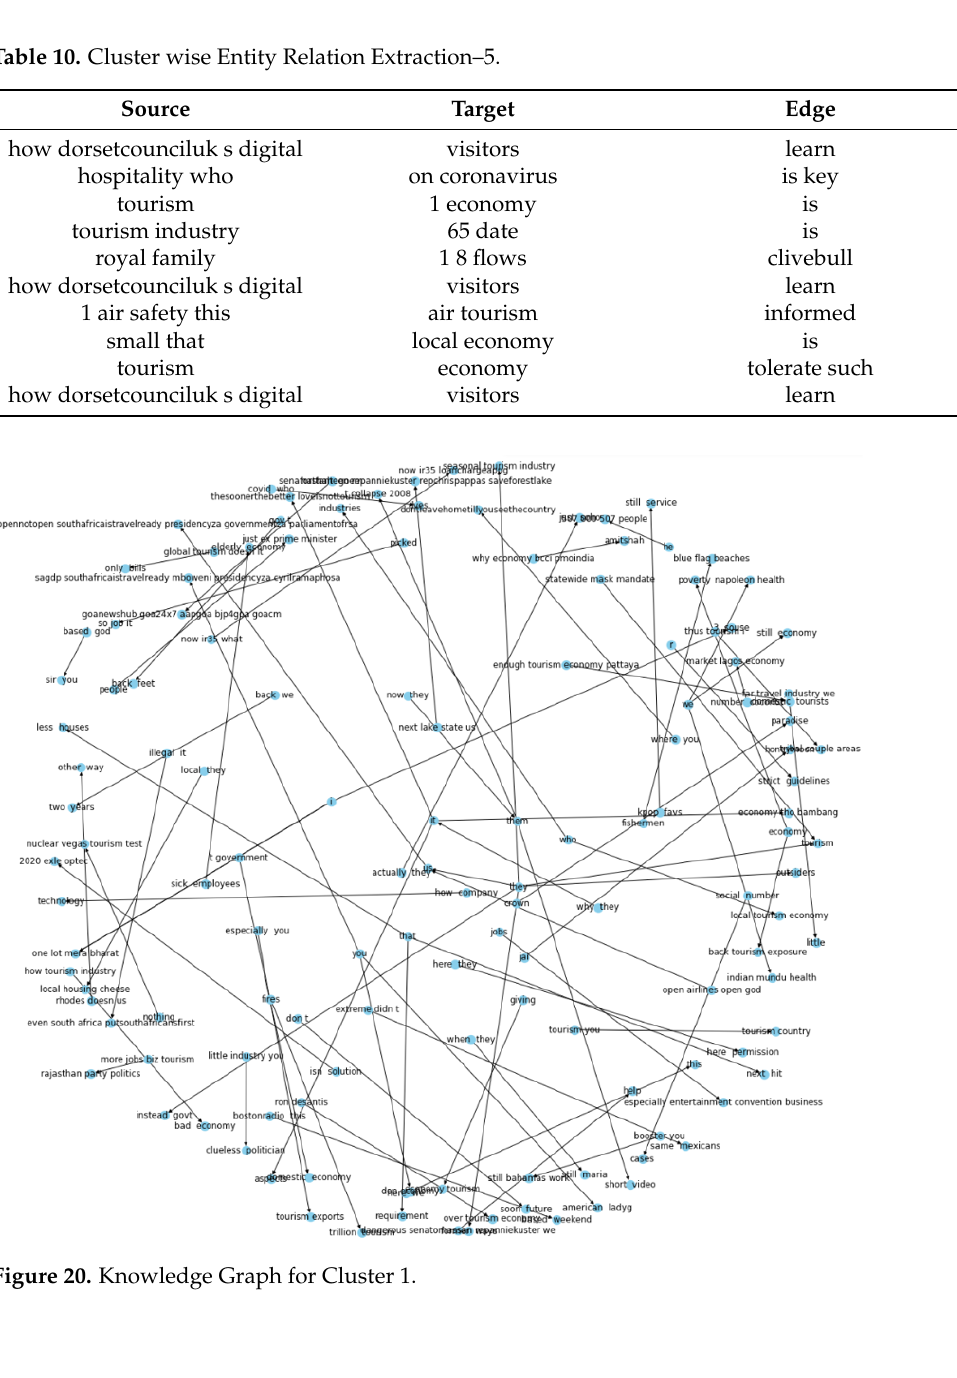
Figure 21. Knowledge Graph for Cluster 2.